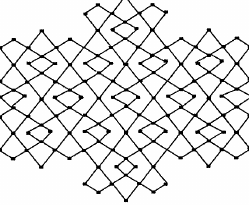
Figure 3. Dominating David derived network of the third type D 3